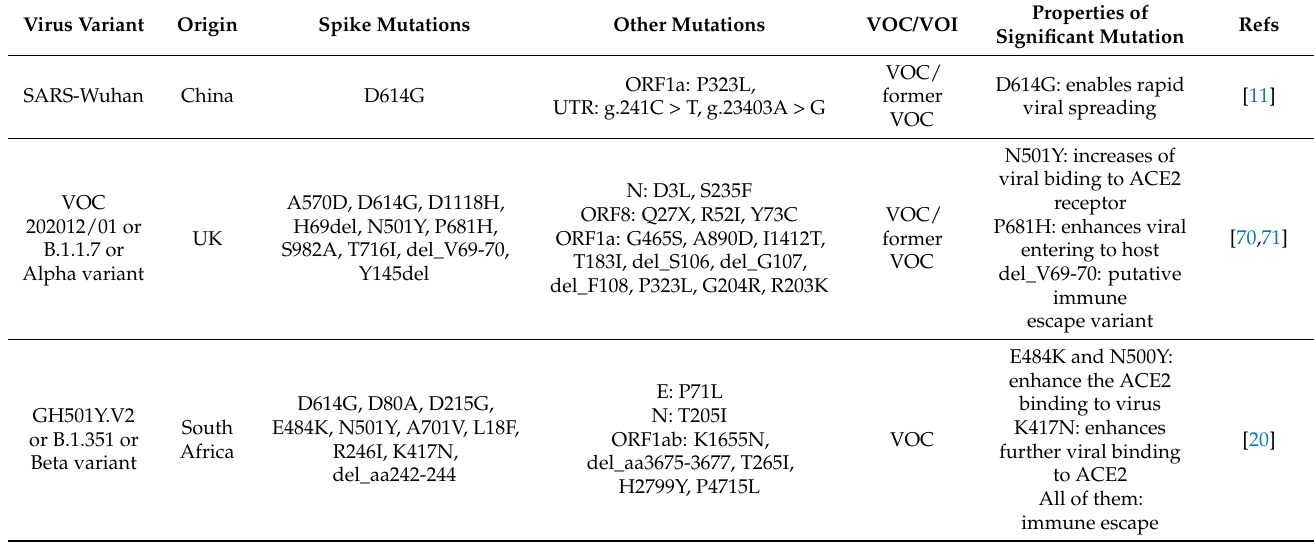
Table 1. VOC or VOI variants of SARS-CoV-2, based on the World Health